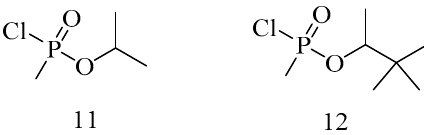
Figure 5. Chlorosarin and chlorosoman.